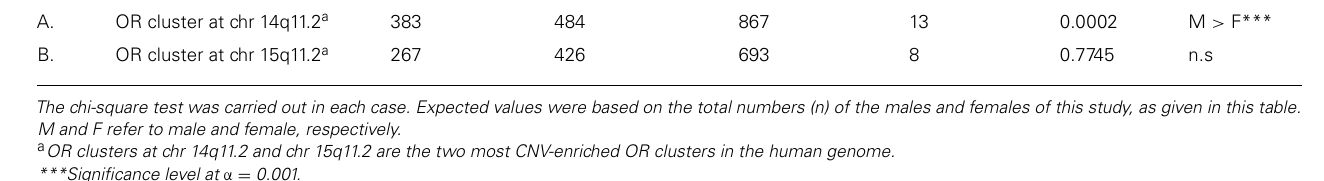
Table 10 | Gender comparisons of the total number of CNVs (loss and gain) between two OR clusters at chr 14q11.2 and chr 15q11.2. Genomic